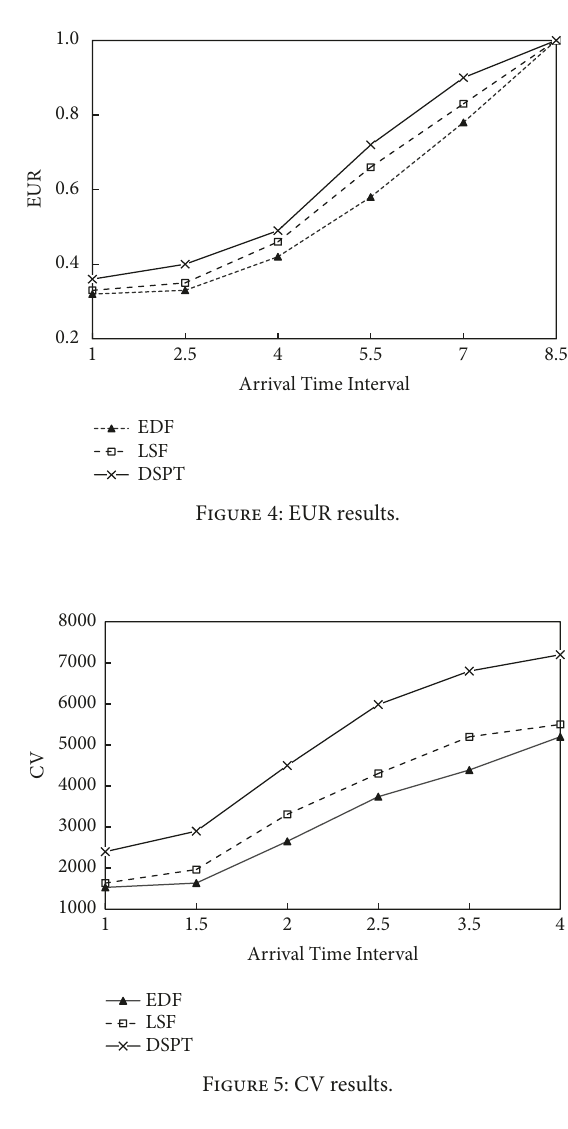
Figure 3: ATDR results.